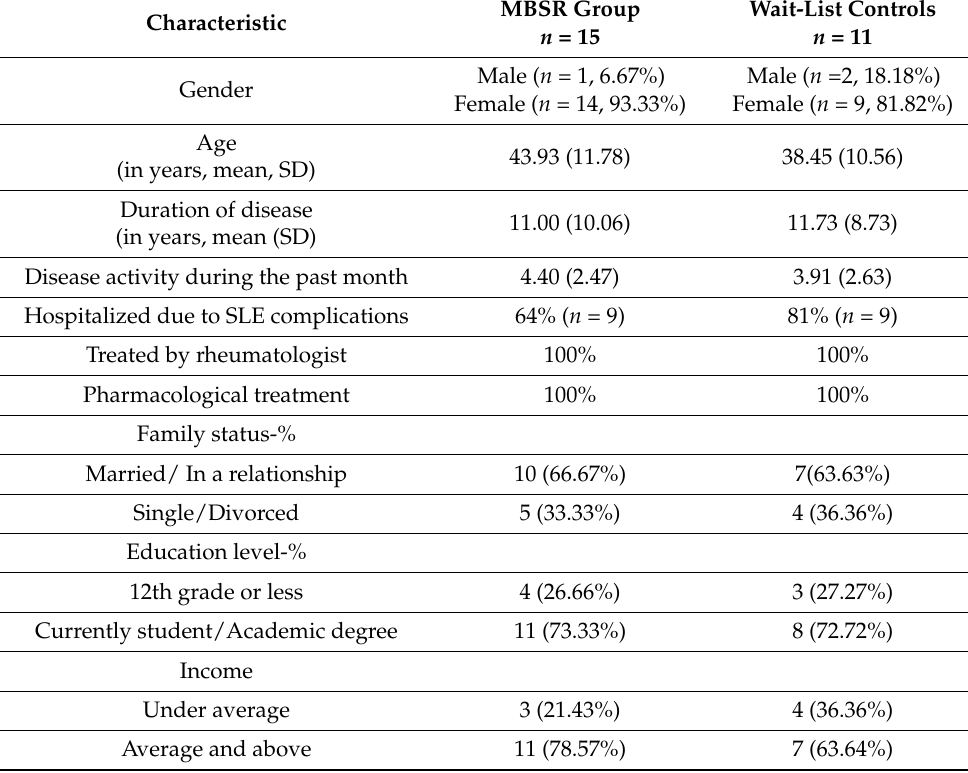
Table 1. Baseline characteristics according to group.